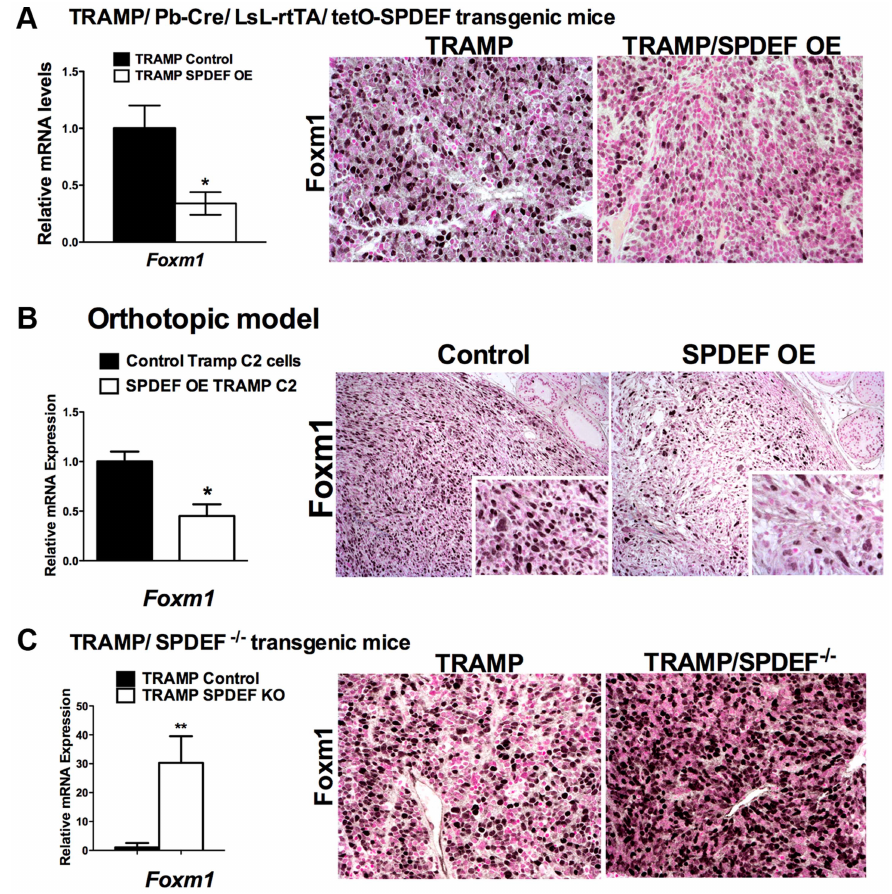
Figure 5. SPDEF and Foxm1 are inversely correlated in prostate carcinogenesis. A . In transgenic TRAMP/SPDEF OE mice, over-expression of SPDEF in prostate epithelial cells decreased Foxm1 mRNA (left panel) and protein (right panels) in prostate tumors. Experimental TRAMP/SPDEF OE and control TRAMP mice were sacrificed at 25 weeks of age. B . In orthotopic mouse model, SPDEF inhibited Foxm1 mRNA and protein levels during prostate carcinogenesis. Lentiviral expression of SPDEF in TRAMP C2 prostate adenocarcinoma cells decreased Foxm1 mRNA shown by qRT-PCR. b - actin mRNA was used for normalization. The decrease of Foxm1 staining in prostate tumors is shown by immunohistochemistry. Mouse prostates were harvested 5 weeks after inoculation of either control TRAMP C2 cells or TRAMP C2 cells expressing SPDEF (SPDEF OE). C . In transgenic TRAMP/ SPDEF 2 / 2 mice, depletion of SPDEF increased Foxm1 mRNA (left panel) and protein levels (right panels). Experimental TRAMP/SPDEF 2 / 2 and control TRAMP mice were sacrificed at 23 weeks of age. Data represent means 6 SD of three independent determinations (n=3–5 mice in each group). Magnification: 200 6 . A p value , 0.01 is shown with (**) and p value , 0.05 is shown with (*). C . Magnification: 200 6 . A p value , 0.01 is shown with (*). Foxm1 in SPDEF OE cells restored the cell cycle progression (Figure 7B, bottom panels) in cultured cells. Furthermore, re- expression of Foxm1 in SPDEF-expressing cancer cells restored tumor weight in orthotopic mouse model of prostate cancer (Figure 7C, left panel), coinciding with increased number of Ki-67-positive (Figure 7D, upper panels) and PH3-positive (Figure 7D, bottom panels) tumor cells. Interestingly, re-expression of Foxm1 in SPDEF-deficient tumor cells restored cell migration (Figure S4A), coinciding with elevated levels of MMP2, MMP9 and MMP13 (Figure S4B). Since SPDEF inhibits cell migration, at least in part, through MMP9 and MM13 [18], increased expression of these MMP genes can contribute to Foxm1-mediated rescue of cell migration in SPDEF-deficient prostate tumor cells. Altogether, these results indicate that SPDEF decreases proliferation and migration of prostate cancer cells through inhibition of Foxm1.